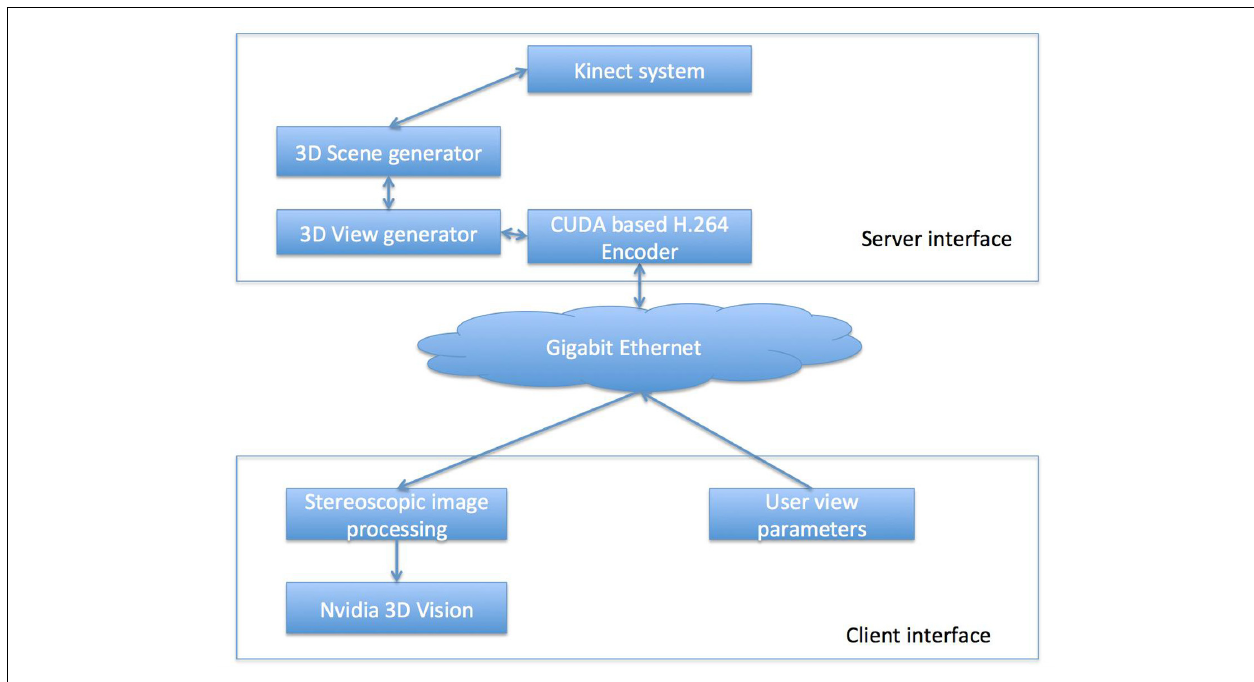
FIGURE 2 |A schematic representation of the proposed tracking system for head and neck radiotherapy.